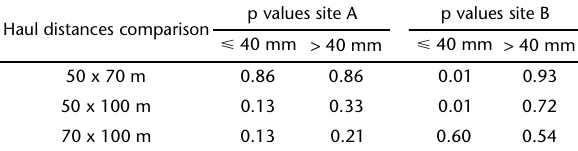
Table III. The resulting p values from Kruskal-Wallis post-hoc test for CPUA between the different haul distances (50, 70 and 100 m), for individuals (cid:2) 40 mm and > 40 mm in total length, for each sampling